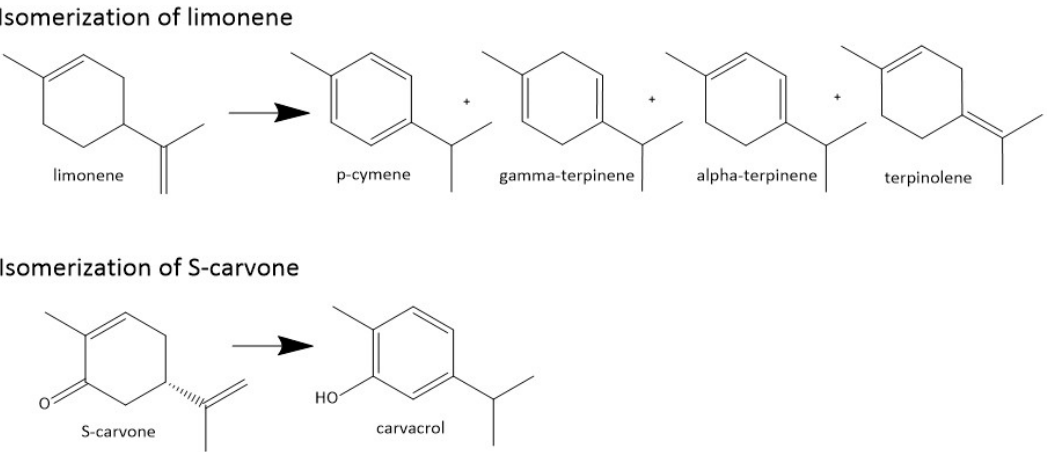
Figure 1. Products of the isomerizations of limonene and S-carvone.